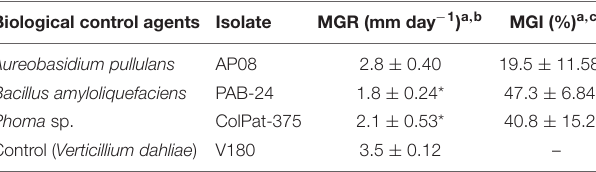
TABLE 2 | Effect of three BCAs on mycelial growth of Verticillium dahliae in dual cultures. Biological control agents